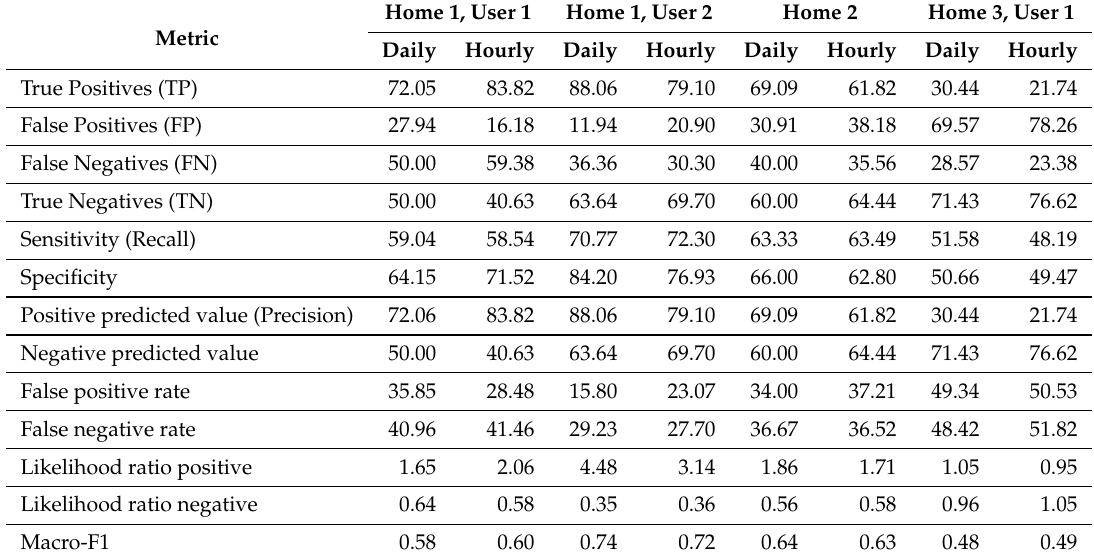
Table 3. Results of health condition